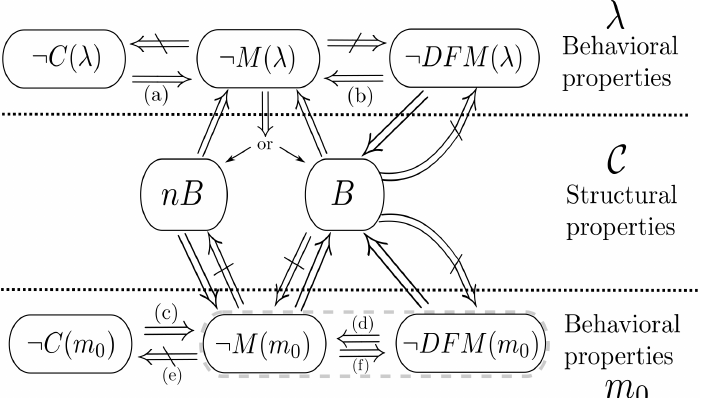
Figure 10. Relationships between configurations and behavioral properties. Continuity, monotonicity, and deadlock-free monotonicity w.r.t. the firing rates are abbreviated as C ( λ ) , M ( λ ) , and DFM ( λ ) , respectively. In the same way, continuity, monotonicity, and deadlock-free monotonicity w.r.t. the initial marking are abbreviated as C ( m 0 ) , M ( m 0 ) , and DFM ( m 0 ) , respectively. Abbreviations nB and B stand for nB-Problematic systems and B-Problematic systems,